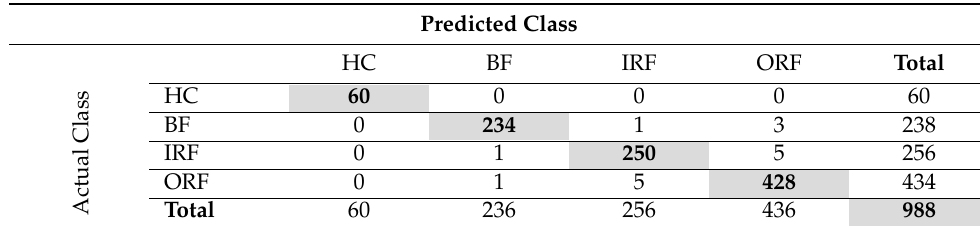
Table 4. The confusion matrix of the testing